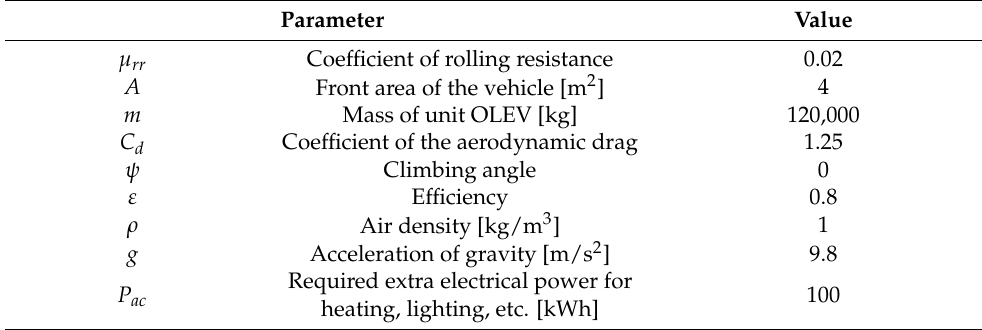
Table 2. System parameters for power modeling.